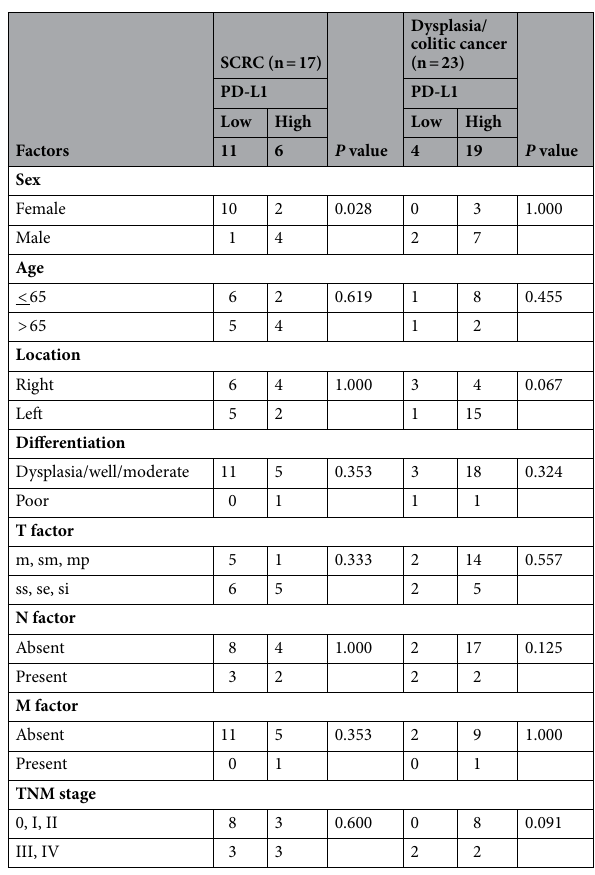
Table 2. Association between the expression of PD-L1 and clinicopathological factors in sporadic colorectal cancer (SCRC) and dysplasia/colitic cancer tissues. Age, sex, M factor, and TNM stage data for dysplasia/colitic cancer are shown for a total of 12 patients, and not for the total 23 lesions analyzed in the